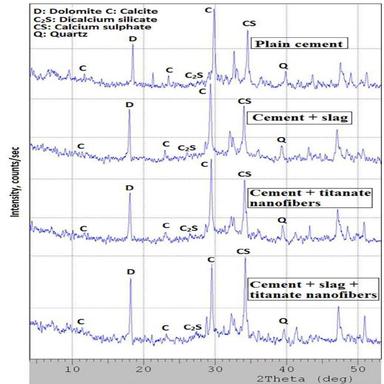
XRD patterns of plain cement and cement improved with slag and/or titanate nanofibers.